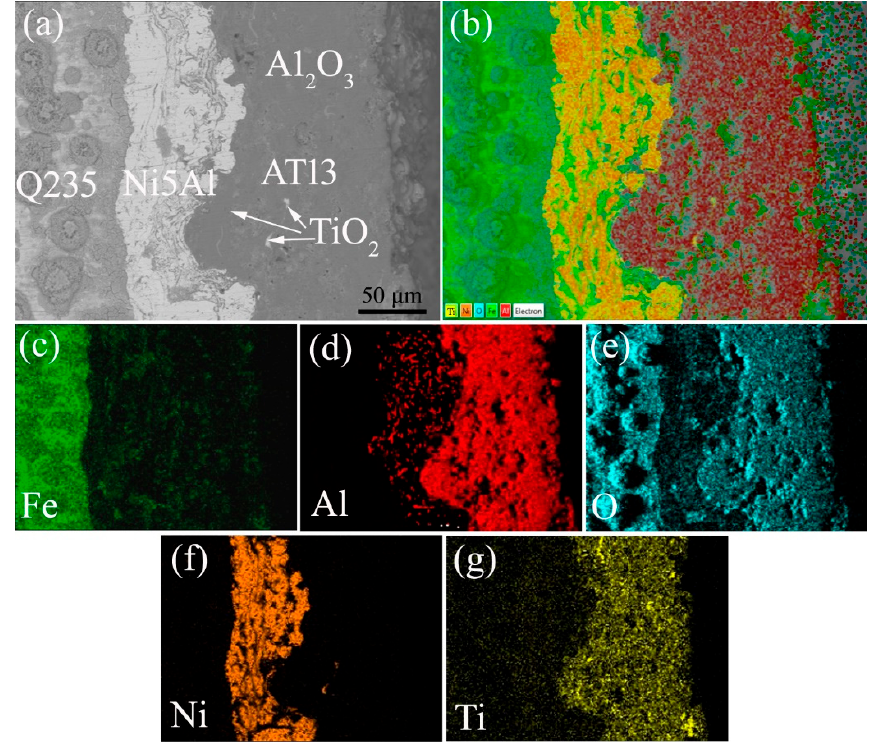
Figure 6. ( a ) Cross-sectional morphology of the coating prepared at optimized parameters and ( b ) the corresponding element mapping of ( c ) Fe, ( d ) Al, ( e ) O, ( f ) Ni, and ( g ) Ti.